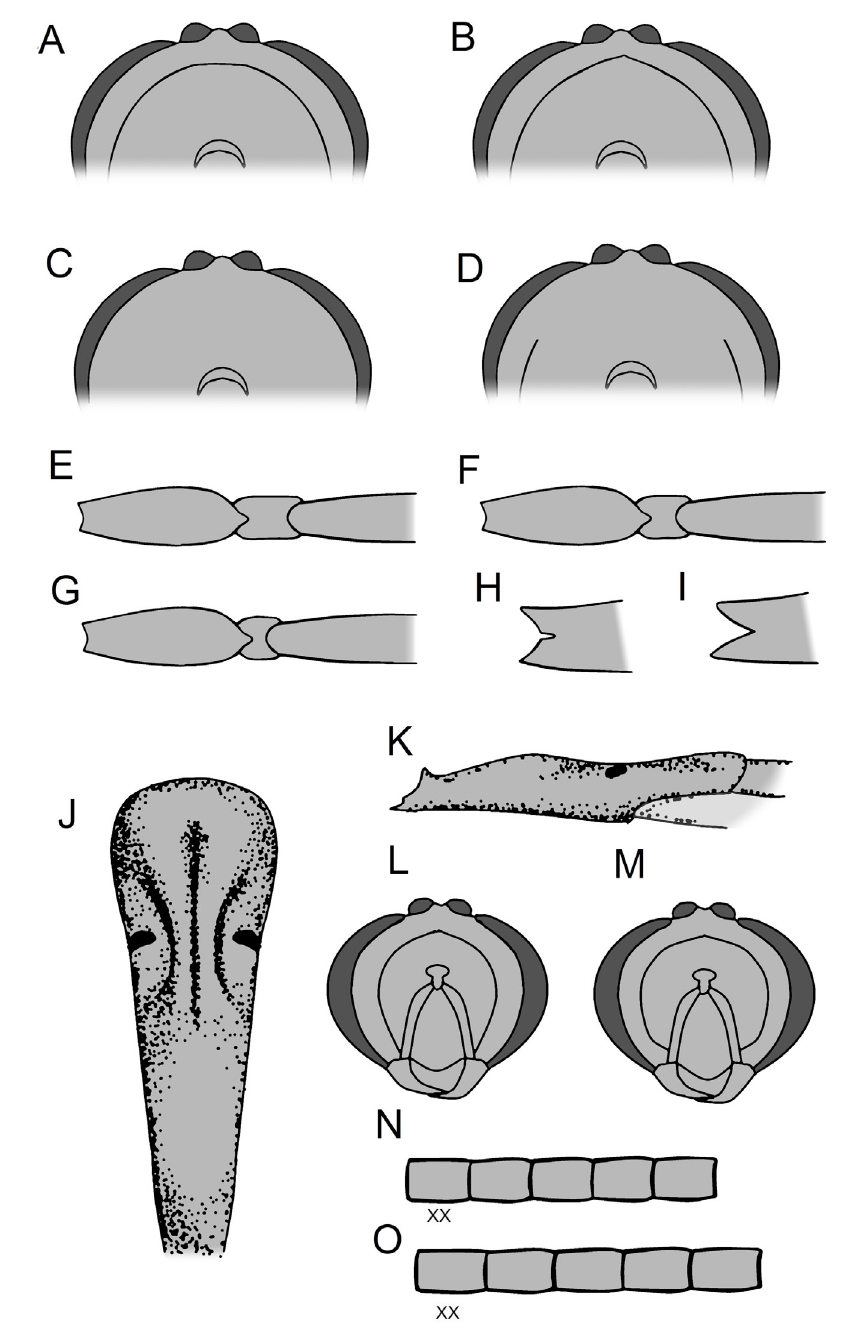
Fig. 7. A–D . occipital carina posterior view. A . Ophion confusus Johansson sp. nov., holotype, ♀ (NhrS-hEVA000008637). B . O. mocsaryi Brauns, 1889. C . O. ocellaris Ulbricht, 1926. D . O. areolaris Brauns, 1889. E–G . hind trochanter and trochantellus dorsal view. E . O. slaviceki